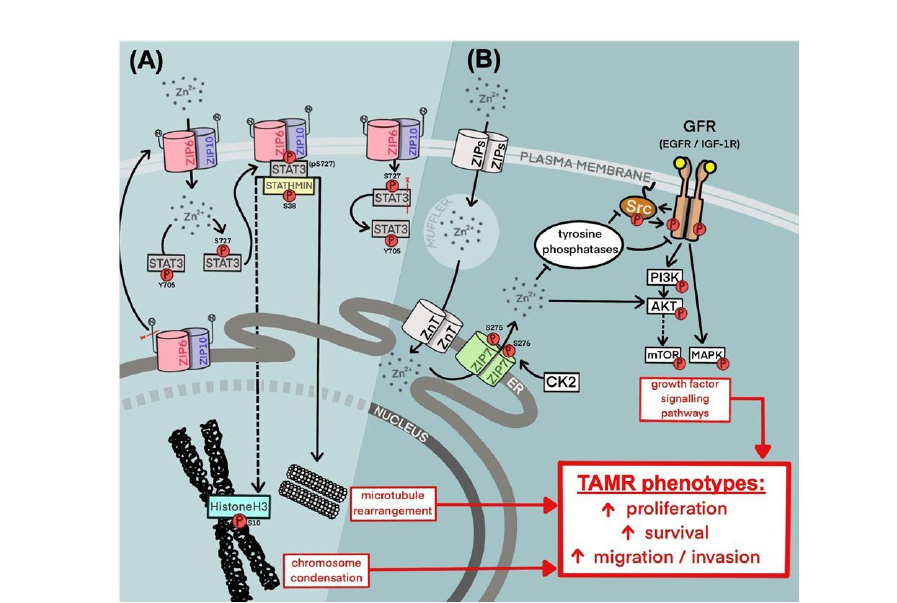
Figure 7. Summary of current knowledge of ZIP6, ZIP10, and ZIP7 contribution to tamoxifen-resistant phenotypes in breast cancer. (A) A mechanism for ZIP6:ZIP10 heterodimer-mediated induction of mitosis. Red lines represent the sites of protein cleavage. (B) A mechanism for stimulation of growth factor signalling via ZIP7-mediated intracellular zinc transport. cdh1: E-cadherin; elp1: elongator acetyltransferase complex subunit 1; ER: endoplasmic reticulum; CDK2: cyclin-dependent kinase 2; PI3K: phosphoinositide-3-kinase; mTOR: mammalian target of rapamycin; Src: proto-oncogene tyrosine-protein kinase